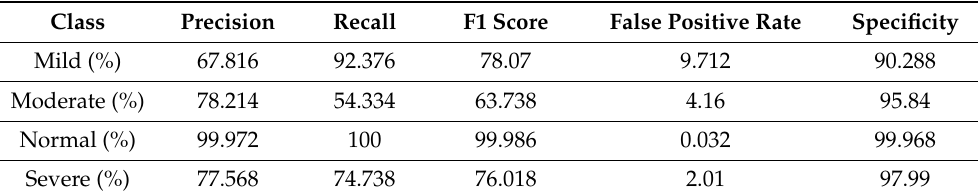
Table 5. The mean evaluation metrics for each class when considering 5-fold cross validation for the best model (Resnet 50).